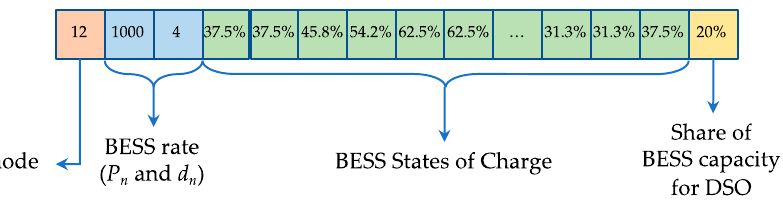
Figure 1. Chromosome section for a storage